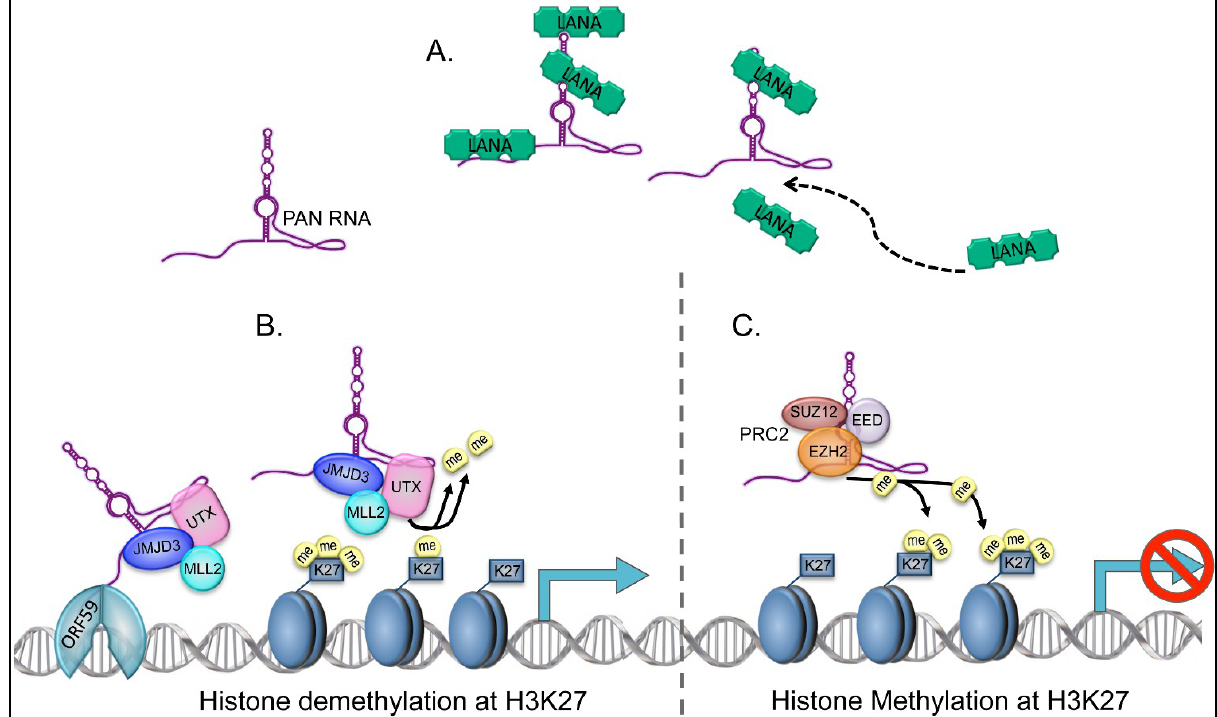
Figure 2. PAN RNA both activates and represses gene expression depending on its interaction with chromatin modifying complexes. ( A ) The interaction of PAN RNA with LANA during reactivation is partly responsible for the LANA-episome dissociation allowing for the expression of lytic transcripts. In this model PAN RNA acts as a “sponge” to keep LANA from repressing viral gene expression; ( B ) The interaction of PAN RNA with UTX/JMJD3 targets H3K37 for demethylation and acts to increase gene expression. The interaction of PAN RNA with viral encoded processivity factor ORF59 may aid in the targeting UTX/JMJD3 to viral genes during lytic gene expression; ( C) PAN RNA’s interaction with PRC2 targets H3K27 for methylation and acts to repress gene expression. The mechanism for specific targeting of PAN RNA is currently under